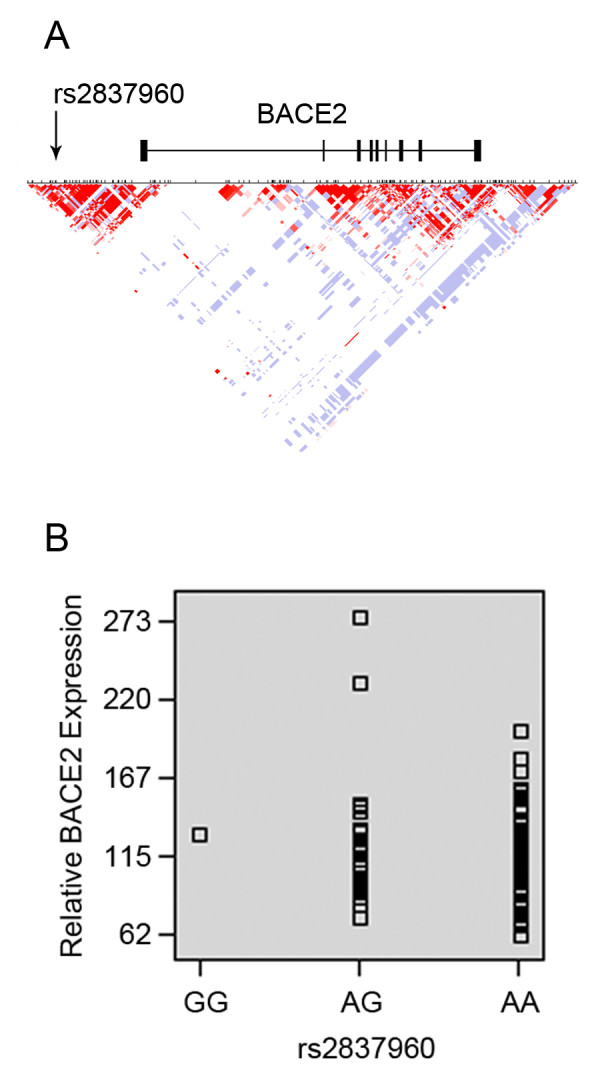
Location of s2837960 and trend between rs2837960 and BACE2 expression. The gene nearest to rs2837960 is BACE2, whose transcription start site is ~27.8 kb downstream. (A) Analysis of the HapMap CEU population reveals that rs2837960 resides within a linkage disequilibrium block that includes the BACE2 promoter region and first exon. (B) Analysis of exon tiling array data within the SNPExpress database suggests a trend between rs3837960_G and increased BACE2 expression (p = 0.08).